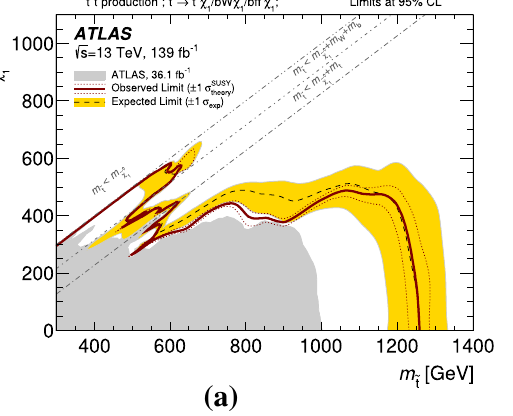
Fig. 13 Observed (red solid line) and expected (black dashed line) exclusion contours at 95% CL as a function of the a ˜ χ 0 1 vs ˜ t masses and b (cid:10) m ( ˜ t , ˜ χ 0 1 ) vs ˜ t mass. Masses that are within the contours are excluded. Uncertainty bands corresponding to the ± 1 σ variation of the